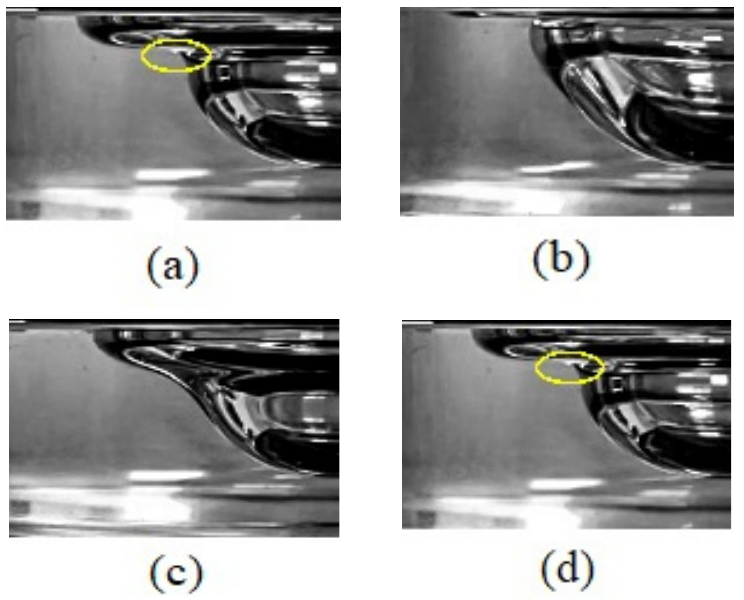
Figure 6. Transfer process of the surface wave. ( a ) is the air–liquid interface contour at 68 s, ( b ) is the air–liquid interface contour at 87 s, ( c ) is the air–liquid interface contour at 107 s, ( d ) is the air–liquid interface contour at 118 s.